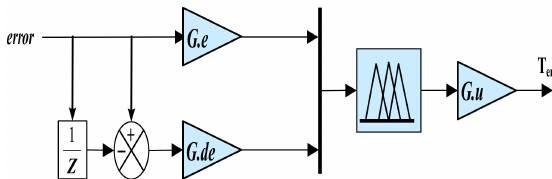
Figure 8. Fuzzy logic MPPT controller. Table 1. Set of rules generated for FLC.